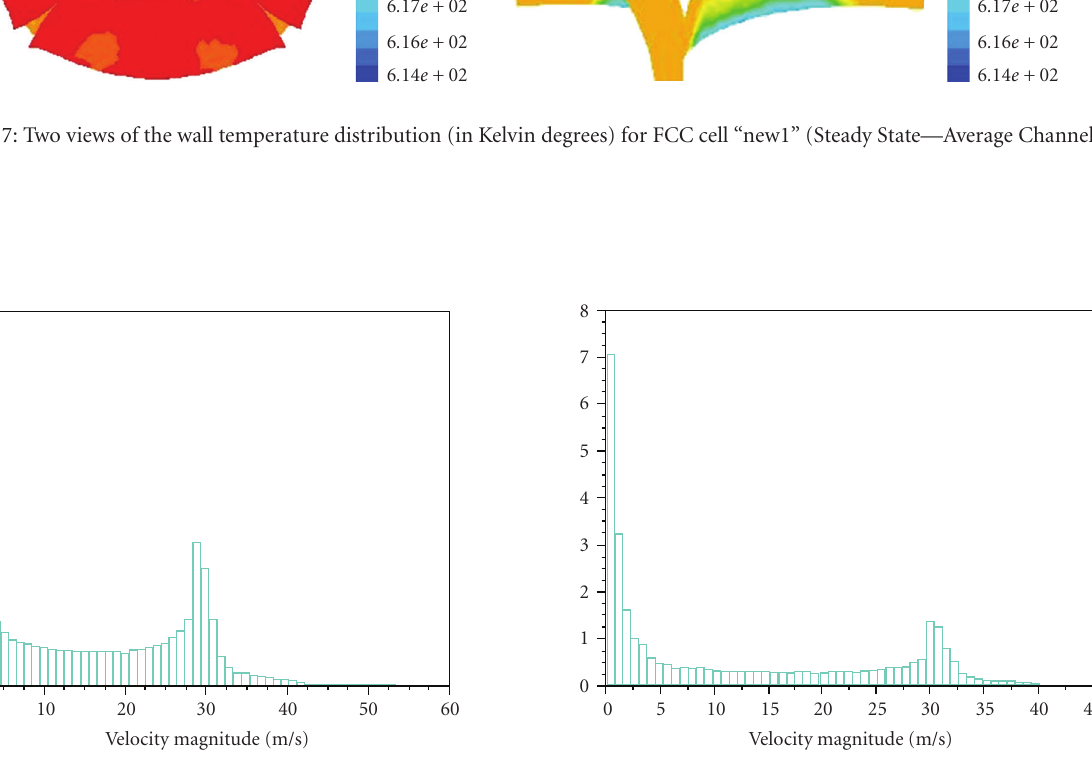
Figure 8: Bar chart showing (normalized) number of points versus velocity for SC cell “new1” (Steady State—Average Channel).